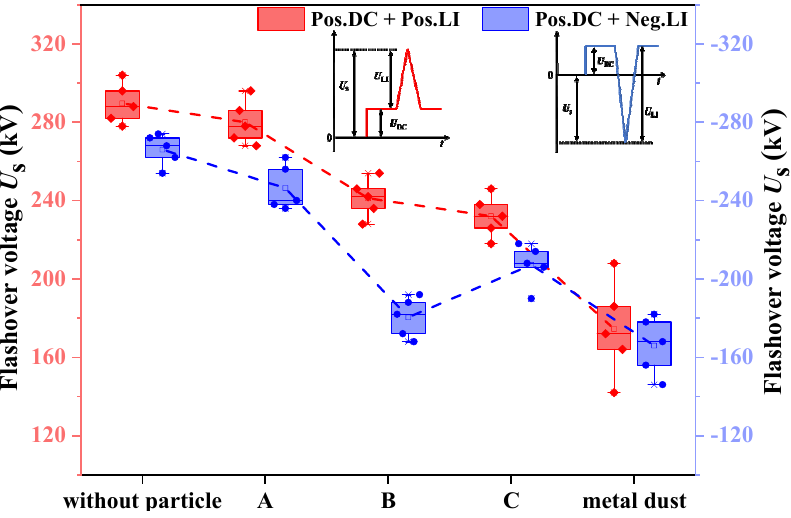
Figure 12. Relationship between flashover voltage of tri–post epoxy insulator and the position of metal contaminants.